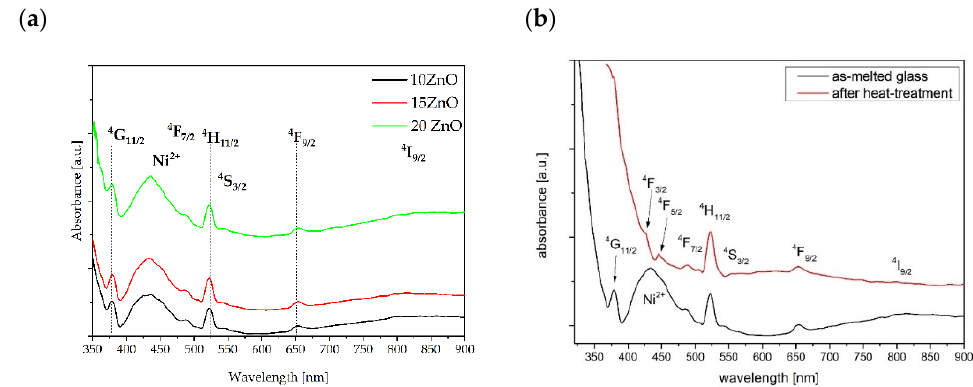
Figure 7. Absorbance spectra of fabricated GGK glasses co-doped with 0.1NiO/0.1Er 2 O 3 and: ( a ) different molar concentration of ZnO, ( b ) 15ZnO before (black line) and after (red line) controllable heat treatment (HT) process at 650 °C for 5 h.